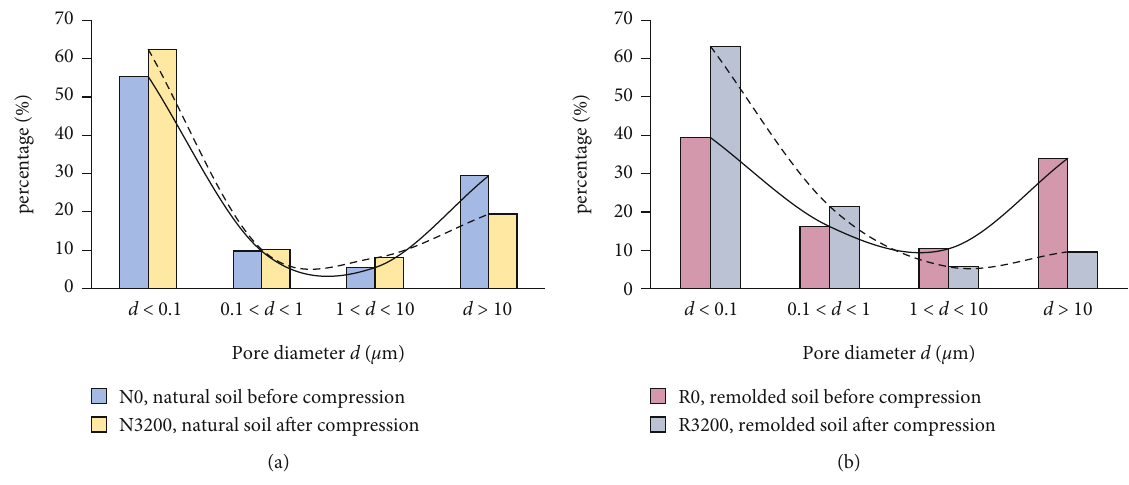
Figure 8: Pore size distributions of GRS before and after compression: (a) natural soil and (b) remolded